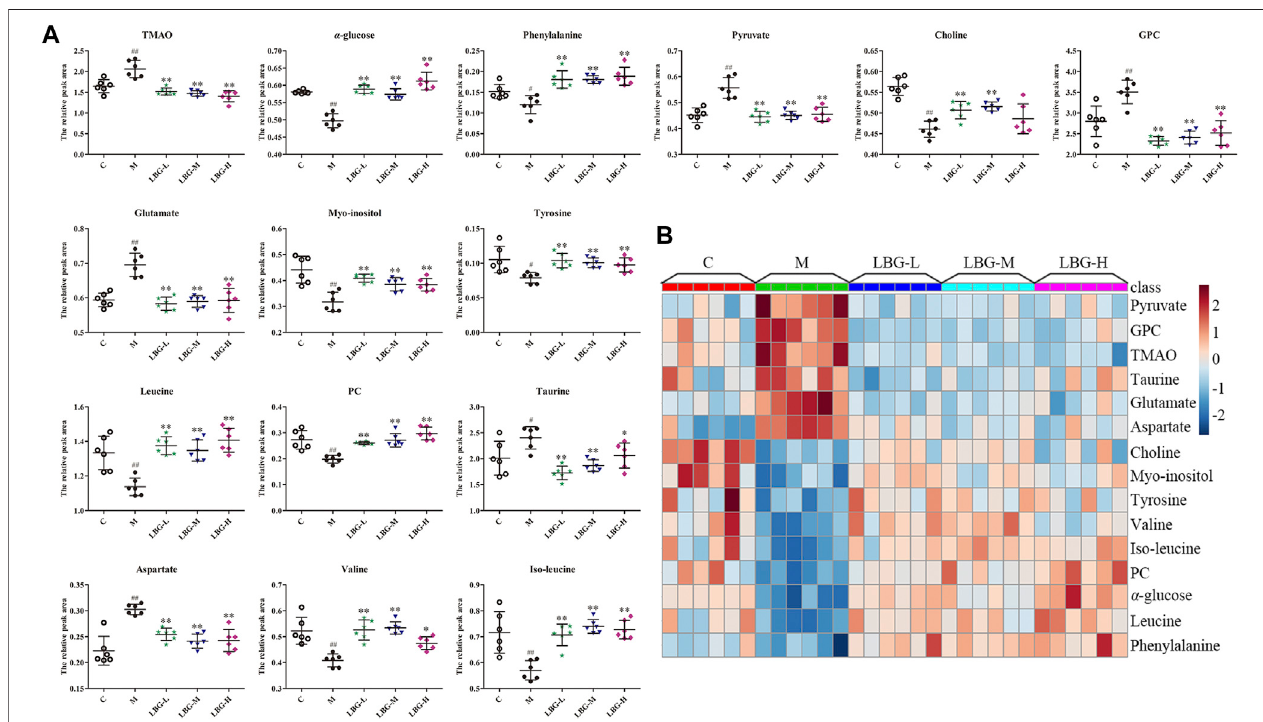
FIGURE 4 | (A) Box-plots of the changes of differential metabolites of mice spleens in C, M and LBG groups. Data are expressed as mean ± SD. # p < 0.05 vs. C group; ## p < 0.01 vs. C group; * p < 0.05 vs. M group; ** p < 0.01 vs. M group. (B) The relative content of the heatmap of differential metabolites in mice spleens. The ribbon − 3 ∼ 3: represents the relative content of the differential metabolites from low to